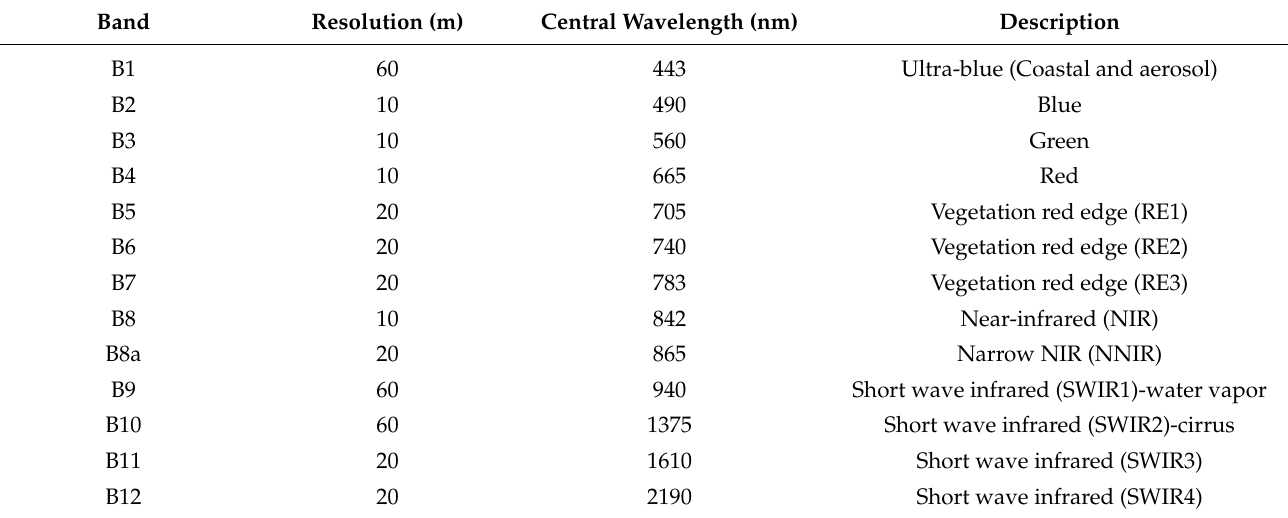
Table 2. Sentinel-2 multispectral sensor wavebands, description, resolution, and their respective central wavelengths. Bands 1, 9, and 10 were excluded from this